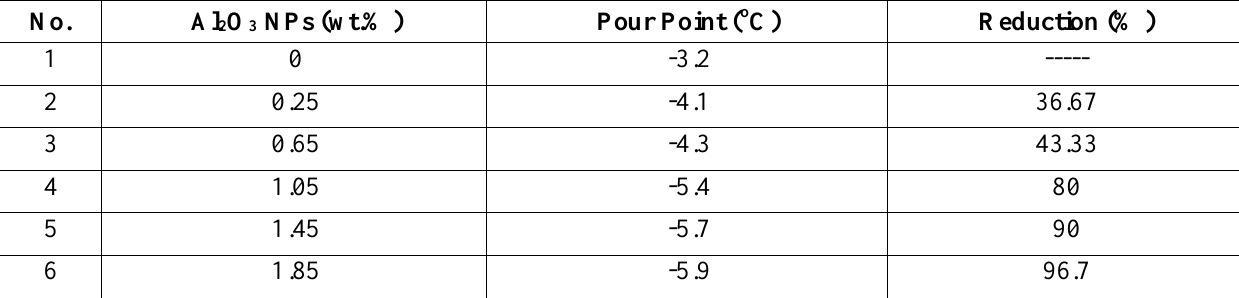
Table 5: Variation of pour point at diverse concentrations of the Al 2 O 3 nano-lubricants.